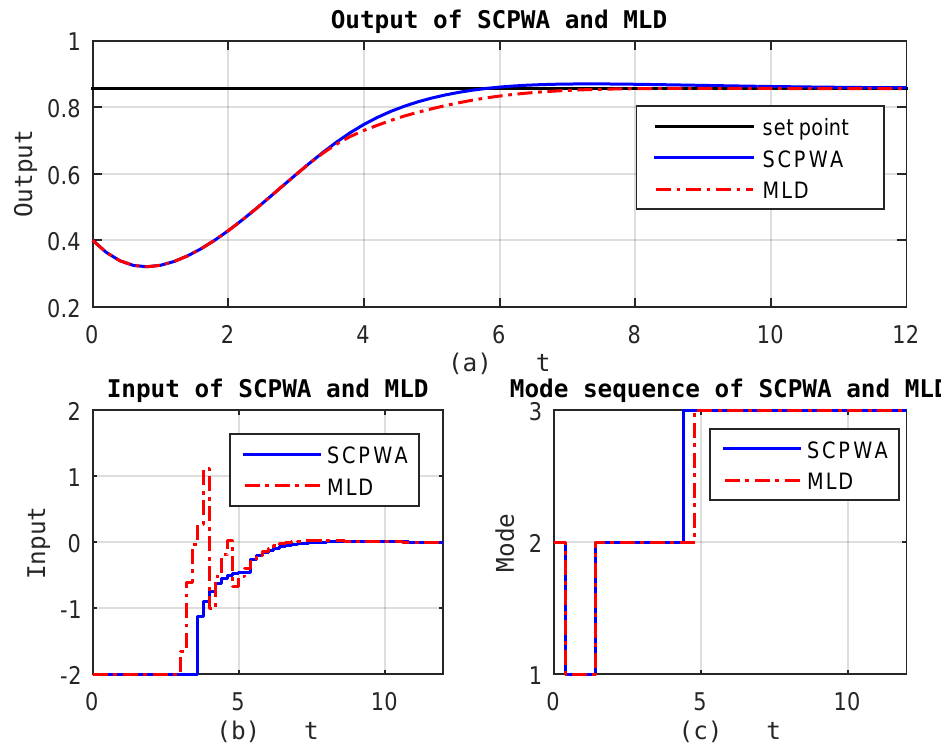
Figure 4. Trajectories of output, input and mode of SCPWA and MLD-based MPC, respectively, in case study 1 of the non-operating point to operating